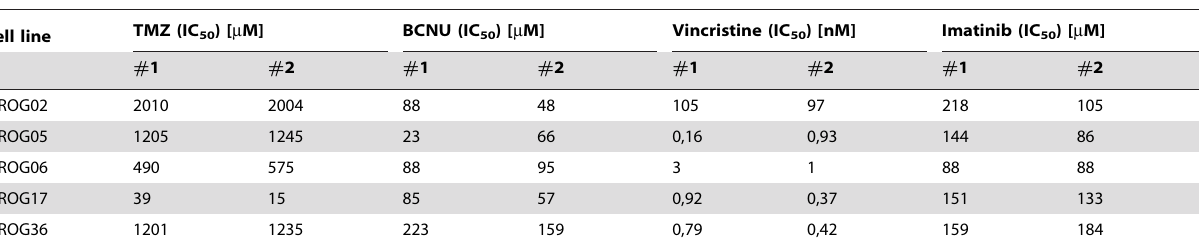
Table 5. IC 50 values.